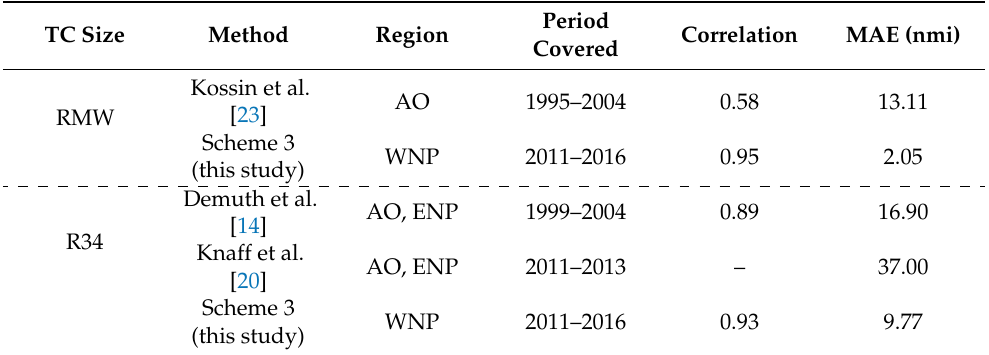
Table 3. Comparison of the best-performing model in this study with other TC size estimation models in terms of the correlation and MAE. AO, WNP, and ENP represent the Atlantic Ocean, western North Pacific, and eastern North Pacific,